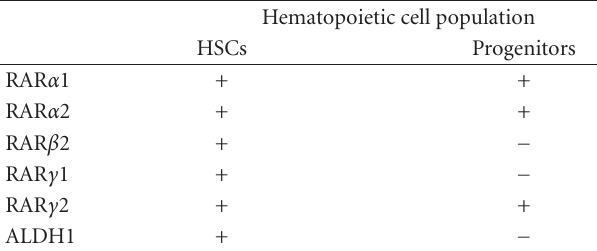
Table 1: Expression of RARs and ALDH1 in murine HSCs and pro- genitor cells. Positive expression is indicated by (+) and negative ex- pression by ( − ). Summary of data is obtained from references [27] and